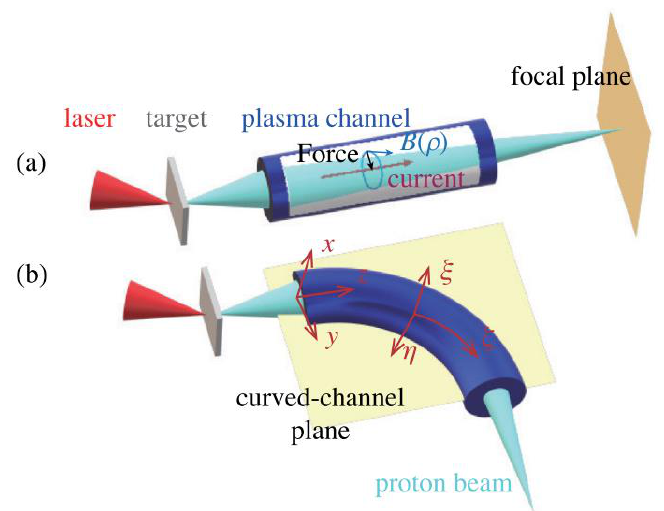
Figure 6. Layout of CLAPA II and its transport system. The overall layout of the beam transport system is in the red dotted box. The different sections of the beam transport system are circled by dashed lines of different colors.